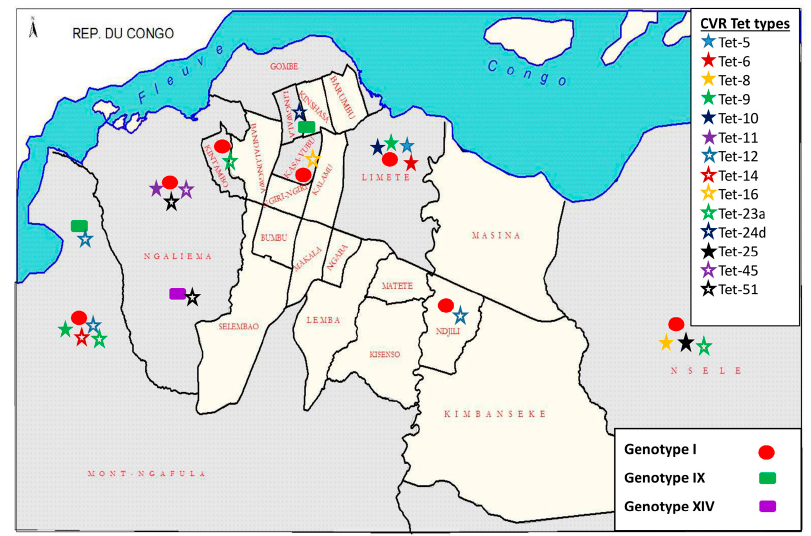
Figure 4. Localization of ASFV p72 genotypes and the corresponding CVR tet ‐ types in this study within the Kinshasa City Province. within the Kinshasa City